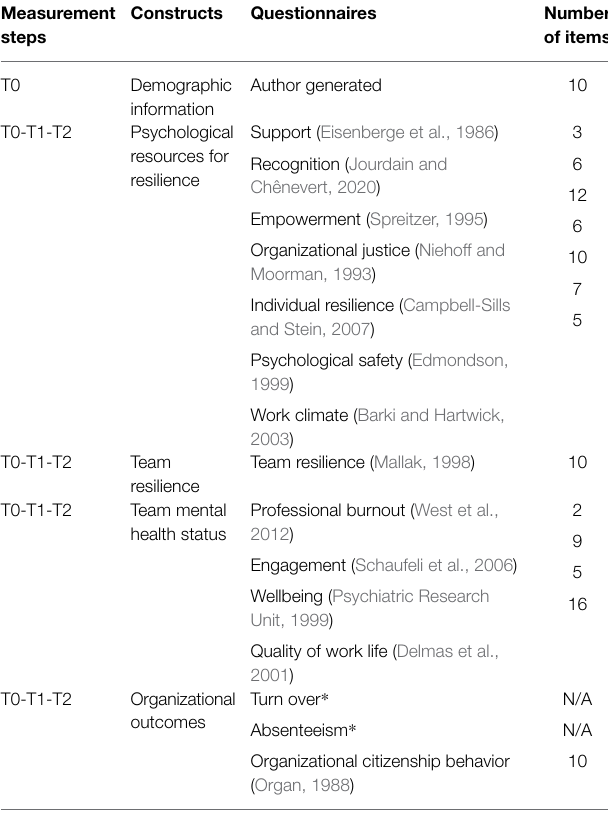
TABLE 3 | Quantitative date collection per study measurement